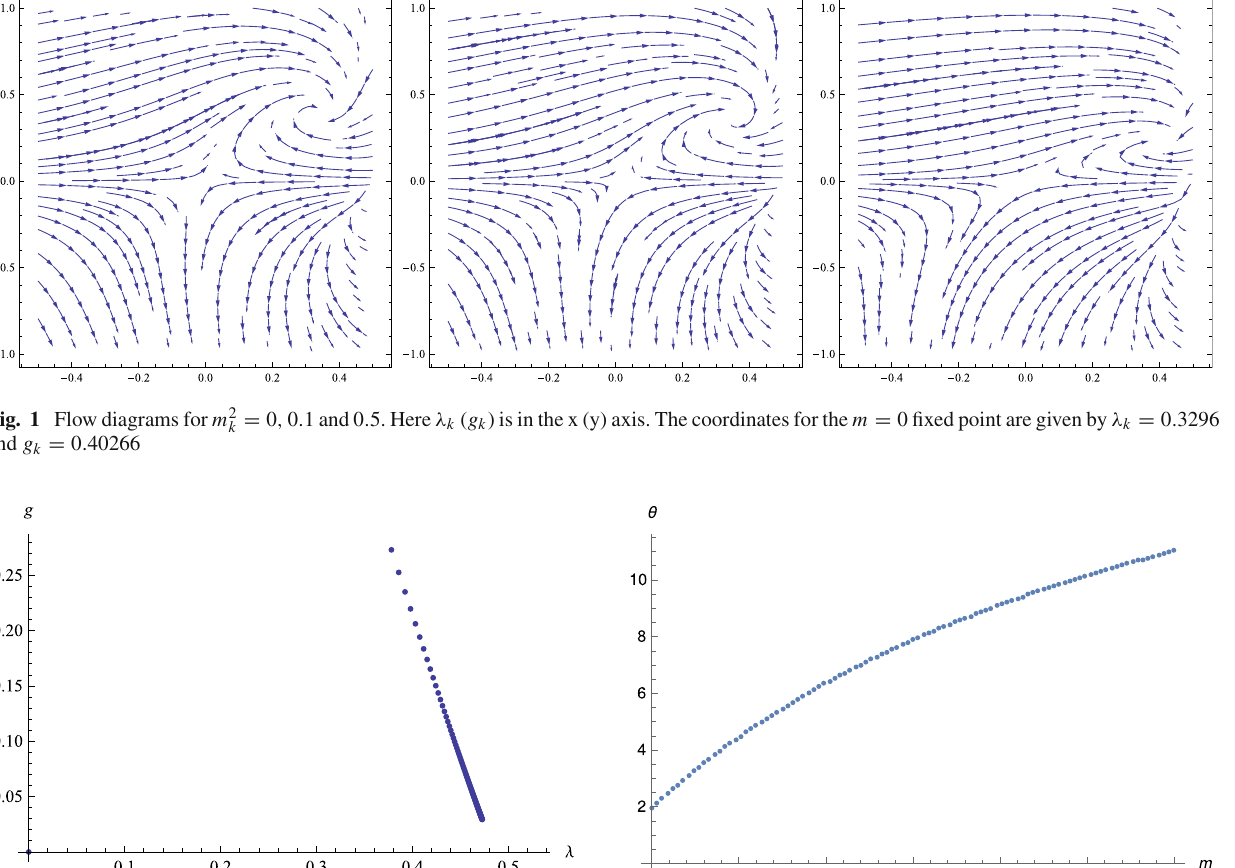
Fig. 3 The real part θ of the critical exponent is positive and grows with the dimensionless mass m 2